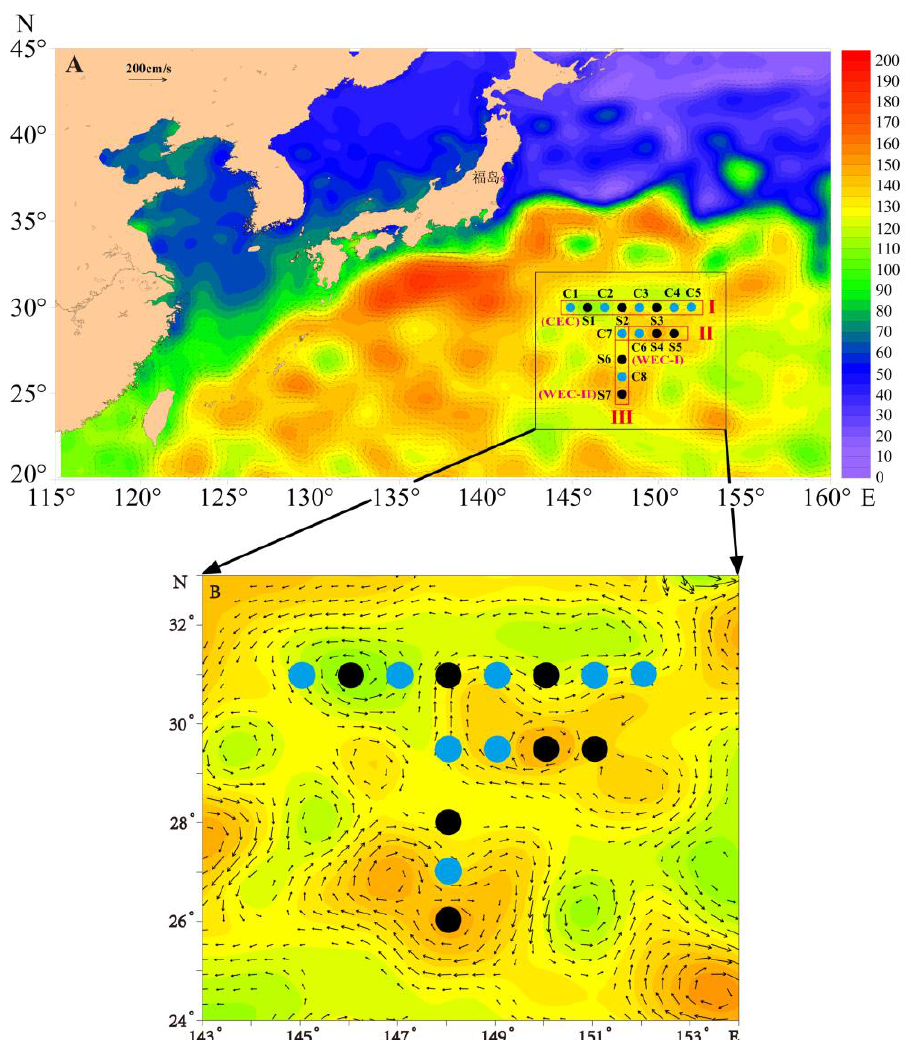
Figure 1. ( A ) Maps of northwestern Pacific showing the sea surface dynamic topography (cm) with geostrophic current (black vectors in cm/s). ( B ) The locations of sampling stations during the 10 to 14 June 2012 cruise are shown as solid dots, and stations for only physical (temperature and salinity, density) and biogeochemical (hydrography, biology and nutrients) variables analyses are marked in cyan and black, respectively. All stations are shown enlarged for a clearer view of their relative position to the cyclonic and anticyclonic circulation patterns.